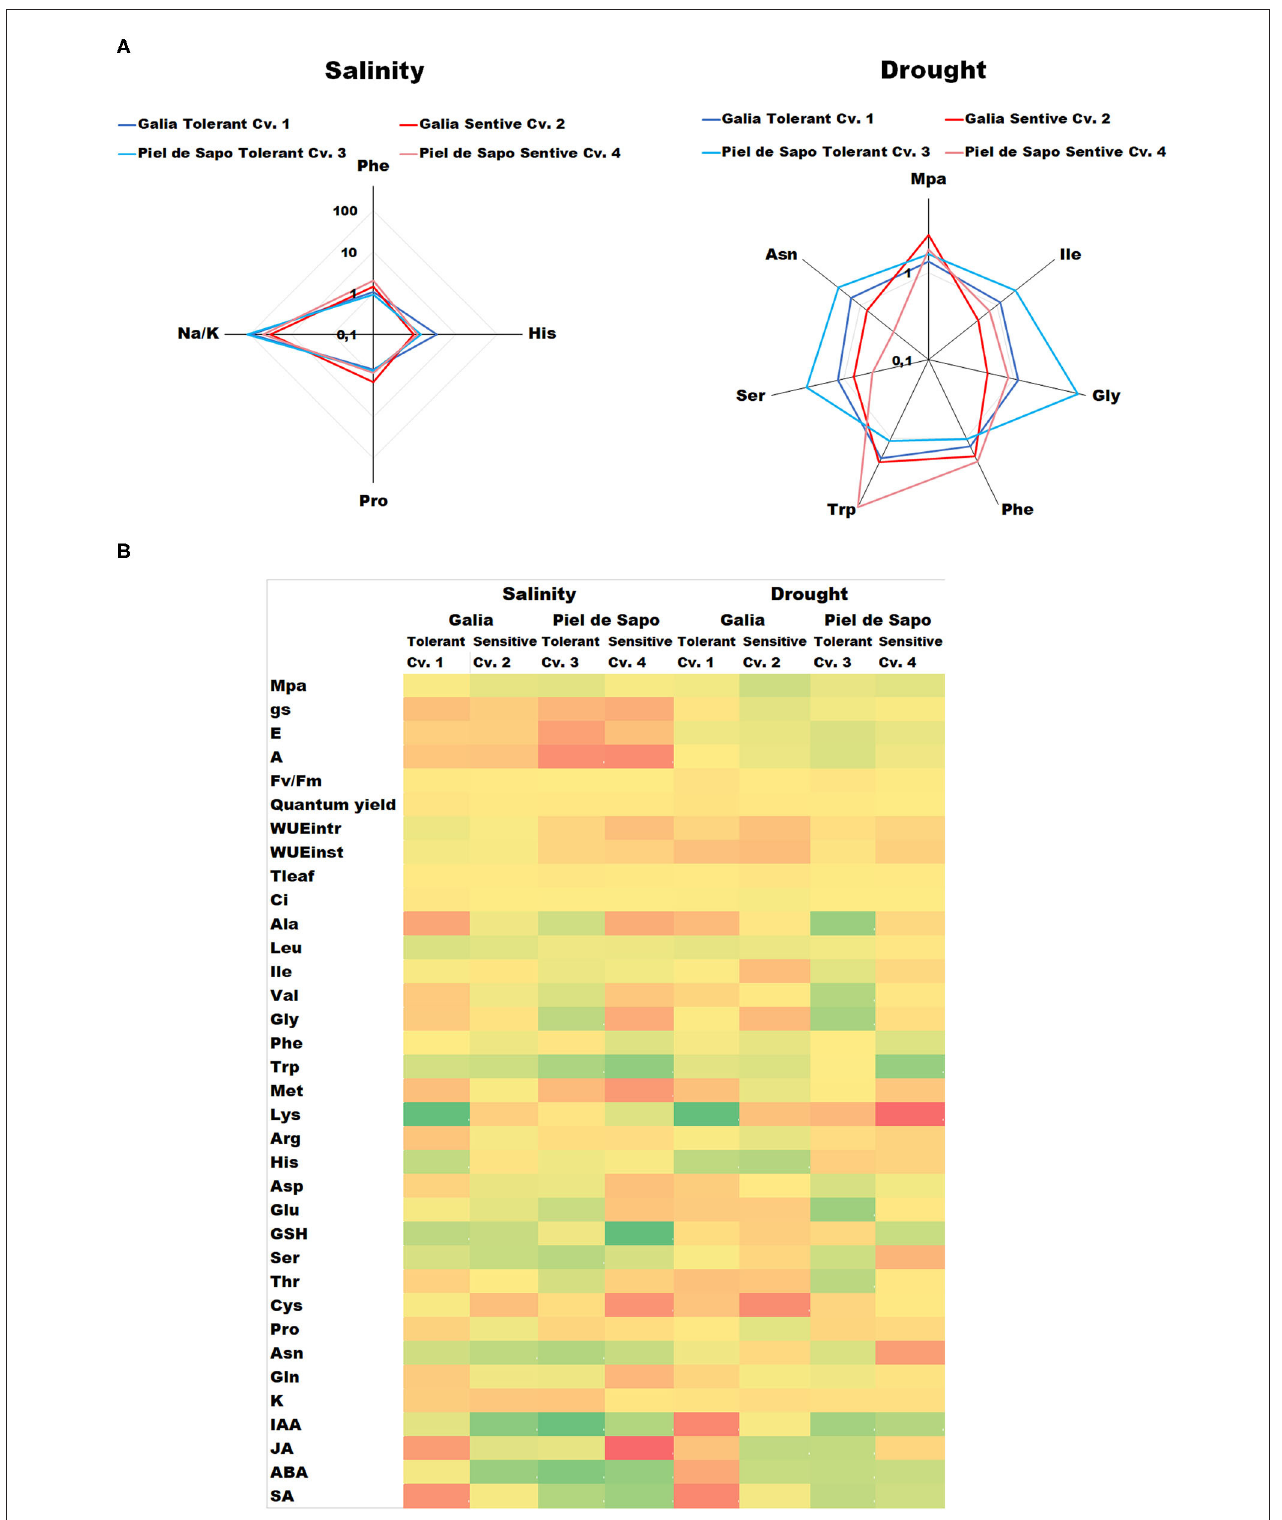
FIGURE 7 | Summary of the main findings of this study. (A) Radial diagrams of the ratio between stress/control concentration under salt stress (left) or stress/control concentration under drought stress (right). The tolerant cultivars are shown in shades of blue and the sensitive cultivars in shades of red. The values are represented in a decimal logarithmic scale. (B) Heat map of all the results obtained in the present study. Green indicates higher stress/control values, yellow average stress/control values while red indicates lower stress/control values in a decimal logarithmic scale.